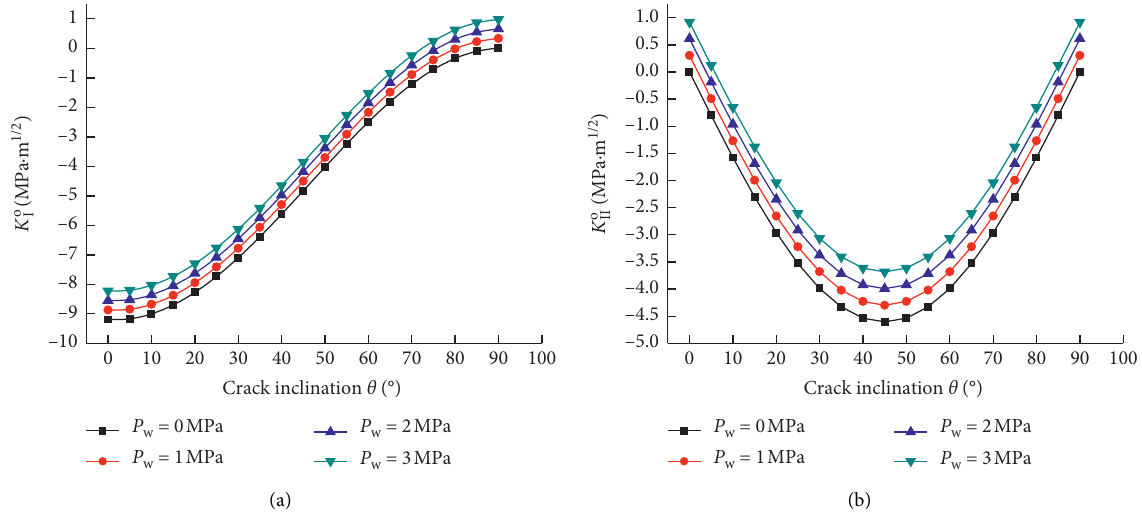
Figure 6: Relationship between crack inclination and stress intensity factor of open cracks with different pore pressures ( σ (a) Mode I. (b) Mode